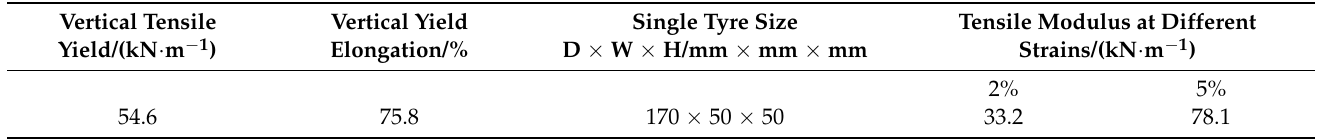
Table 3. Engineering properties of tires.